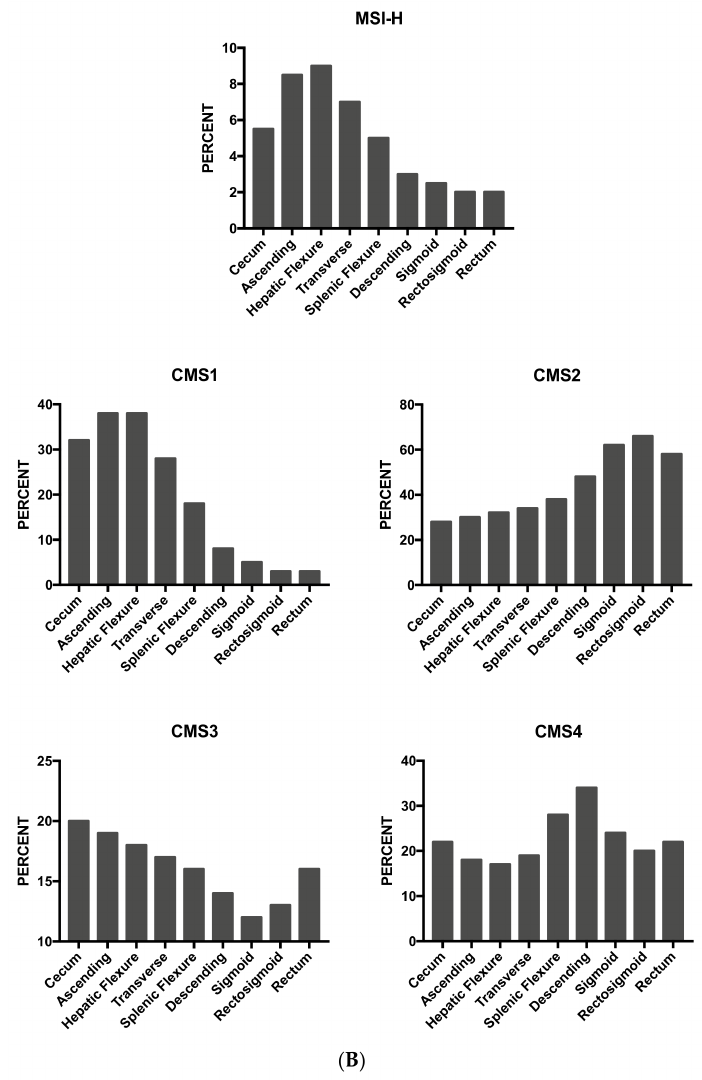
Figure 8. ( A ) Relative prevalence of key oncogenic alterations at specific primary tumor locations in patients with metastatic colon cancer. Panels 1 to 3 from the top to the bottom: frequency of BRAFV600, TP53, SMAD4, CTNNB1, PIK3CA and KRAS/NRAS alterations in primary tumor locations. Bottom pane: frequency of the main oncogenic alterations, consensus molecular subtypes and CIMP-H at the level of right-side colorectal cancer (RSC), left-side colorectal cancer (LSC) and rectum-located colorectal cancers. The data are reported by Loree et al. [242]; ( B ) Relative prevalence of consensus molecular subtypes (CMS) at specific tumor locations. The data are reported by Loree and coworkers [242]. In conclusion, although the current clinical treatment of colorectal cancer does not take into account the primary tumor site, left-sided and right-sided colon cancers harbor different biologic and clinical characteristics. Right-sided colon cancers are more likely to have genome-wide hypermethylation of the CIMP, hypermutated state via MSI-H, and BRAF mutations. Colorectal cancer subtypes are differentially distributed between right- and left-sided colorectal cancers, with a greater frequency of MSI/immune CMS1 and “metabolic” CMS3 subtypes observed in r ight-sided colon cancers. Growing evidence indicates that stage III-IV right-sided colorectal cancers have an inferior prognosis compared to the corresponding tumors located on left-side and that anti-EGFR antibody therapy is associated with better survival on left-side, stage IV colorectal cancers, compared with right-side colorectal